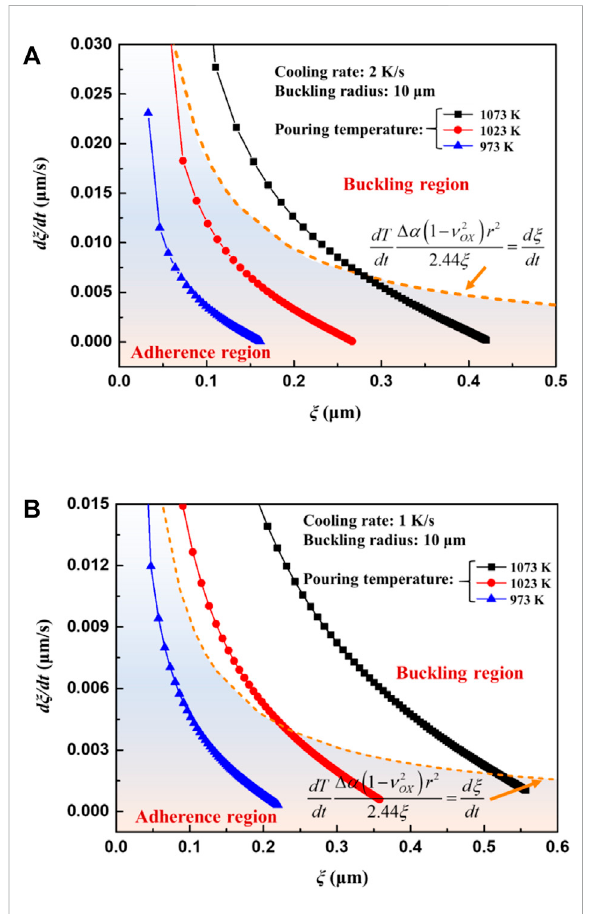
FIGURE 13 The oxide growth rate curves as a function of oxide thickness under different pouring temperatures (A) cooling rate 2 K/s (B) cooling rate 1 K/s.